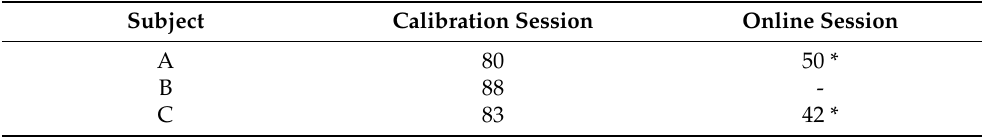
Table 1. Results of classification for individual participants ( n =